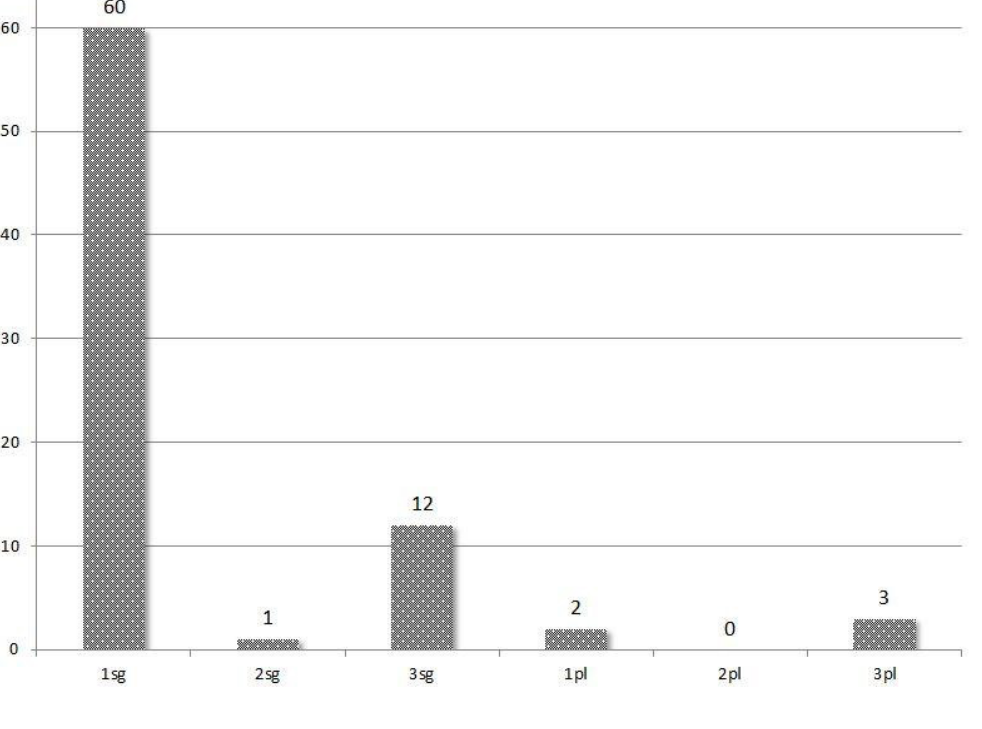
Figure 4. Tener dicho and grammatical person in the CREA-Corpus As an illustration of tengo dicho ‘I have told’ used in dialogal discourse, I give a passage from the short story Las noches del iris negro , written in 1991 by the Spanish novelist Enrique Vila-Matas (see (4)). This example contains several elements that are highly typical of how this item is commonly